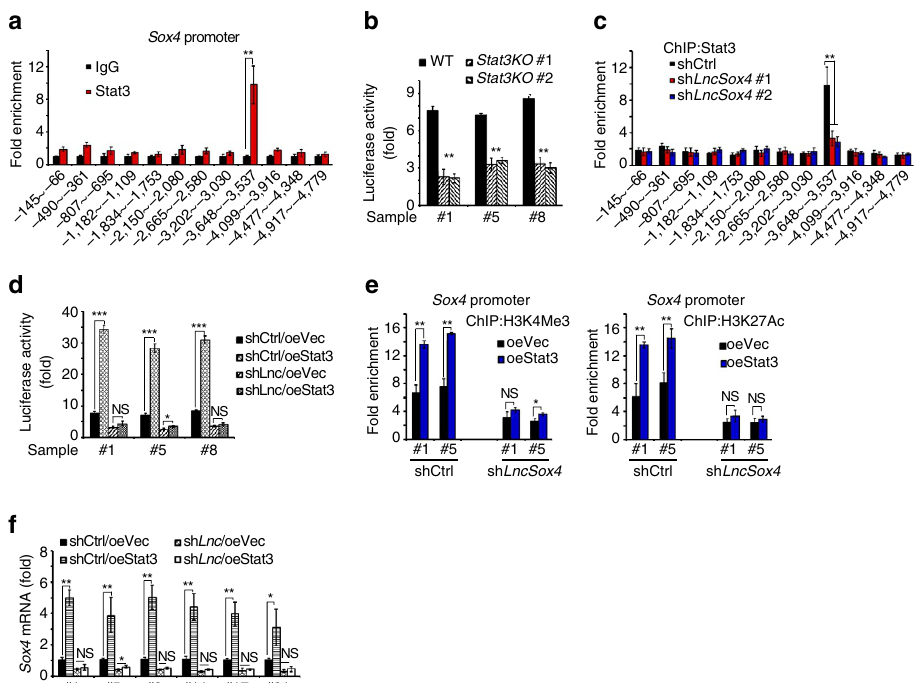
Figure 5 | LncSox4 is required for Stat3 binding to Sox4 promoter. ( a ) Stat3 binds to Sox4 promoter. ChIP assays were performed using anti-Stat3 and control IgG antibodies and fold enrichment of the indicated regions of Sox4 promoter was examined using real-time PCR. ( b ) Stat3 is required for Sox4 promoter activation. Stat3 -deficient cells were established using CRISPR/Cas9 system. Sox4 promoter was constructed into PGL3 luciferase reporter vector and transfected into Stat3 -deficient and control cells. Luciferase triggered by Sox4 promoter activation was measured. ( c ) LncSox4 is required for the interaction between Stat3 and Sox4 promoter. Stat3 ChIP assays were performed using LncSox4 -depleted cells, and enrichment of the indicated regions of Sox4 promoter was examined using real-time PCR. ( d ) LncSox4 is required for Stat3-induced activation of Sox4 promoter. Stat3 were overexpressed in LncSox4 -impaired cells, and then luciferase was examined. Enhanced activation of Sox4 promoter was found upon Stat3 overexpression in control cells, while, comparable activation levels were observed in LncSox4 -silenced cells. ( e ) Stat3 were overexpressed in LncSox4 -silenced cells, followed by ChIP with antibodies against H3K4Me3 (left panels) and H3K27Ac (right panels), and fold enrichment of Sox4 promoter was examined using real-time PCR. oe, overexpression. ( f ) LncSox4 is required for Stat3-induced Sox4 expression. Stat3 were overexpressed in LncSox4 -depleted cells, and then Sox4 expression levels were detected using real-time PCR. Stat3 overexpression induced higher Sox4 expression in control cells but comparable Sox4 expression in LncSox4 - silenced cells. Data were shown as means ± s.d. Two-tailed Student’s t -test was used for statistical analysis. * P o 0.05; ** P o 0.01; *** P o 0.001. P o 0.05 was considered significant. Data are representative of four independent experiments. NS, not